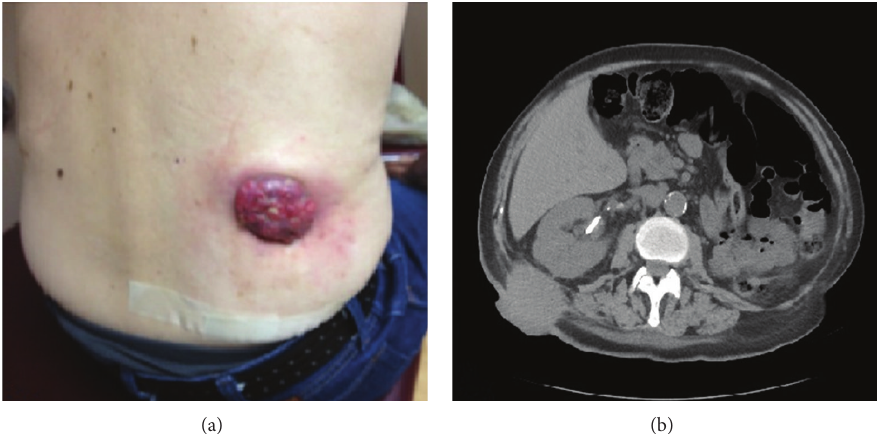
Figure 1: (a) Soft tissue mass at previous traumatically removed nephrostomy site, (b) CT scan revealing extent of the soft tissue mass.